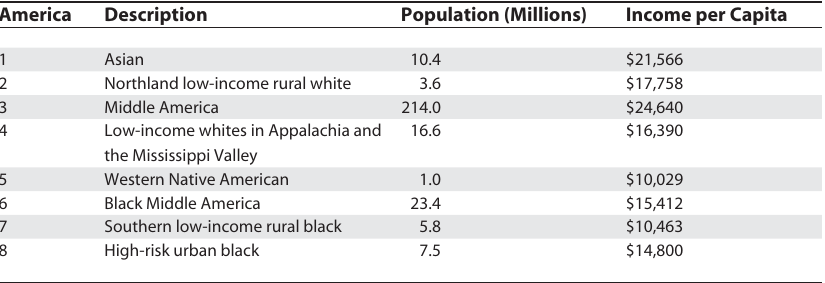
Table 1. The Eight Americas, as Defi ned by Murray and